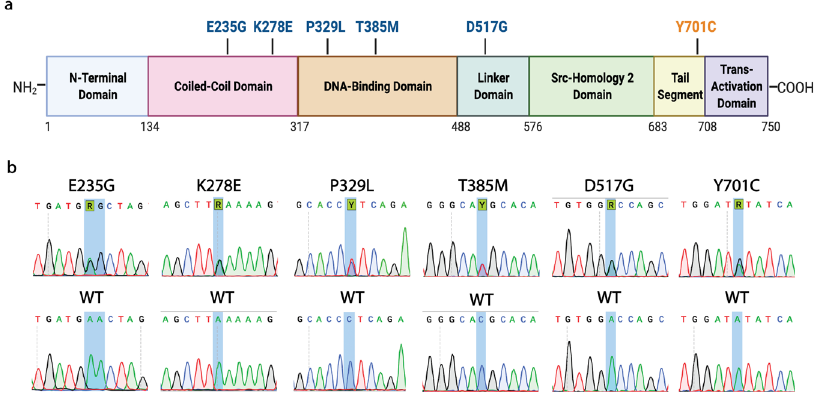
Fig. 1 STAT1 mutations modeled in this work. a Schematic representation of STAT1 mutations selected for modeling and their respectively affected protein domains. Mutations designated in blue (E235G, K278E, P329L, T385M, D517G) are “ gain-of-function ” mutations, while orange (Y701C) designates a “ loss-of-function ” mutation. b Sanger sequencing con fi rmation of generated cell models, compared with their respective wild-type counterparts. Highlighted nucleotides denote the edited base. Note that for E235G, editing of an adjacent “ A ” took place on both alleles, resulting in a silent bystander mutation. This yielded the trinucleotide change: GAA/GAA → GAG/GGG, leading to the amino acid substitution: glutamine/glutamine → glutamine/glycine. This corresponds with the same amino acid change found in patients affected by the E235G